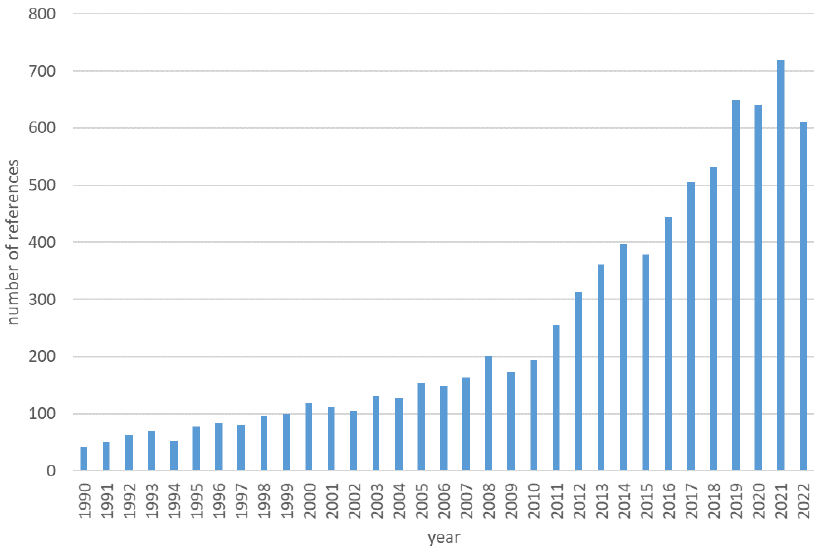
Figure 1. Number of publications on cyclic carbonates in the last 30 years (CAS SciFinder data- base).